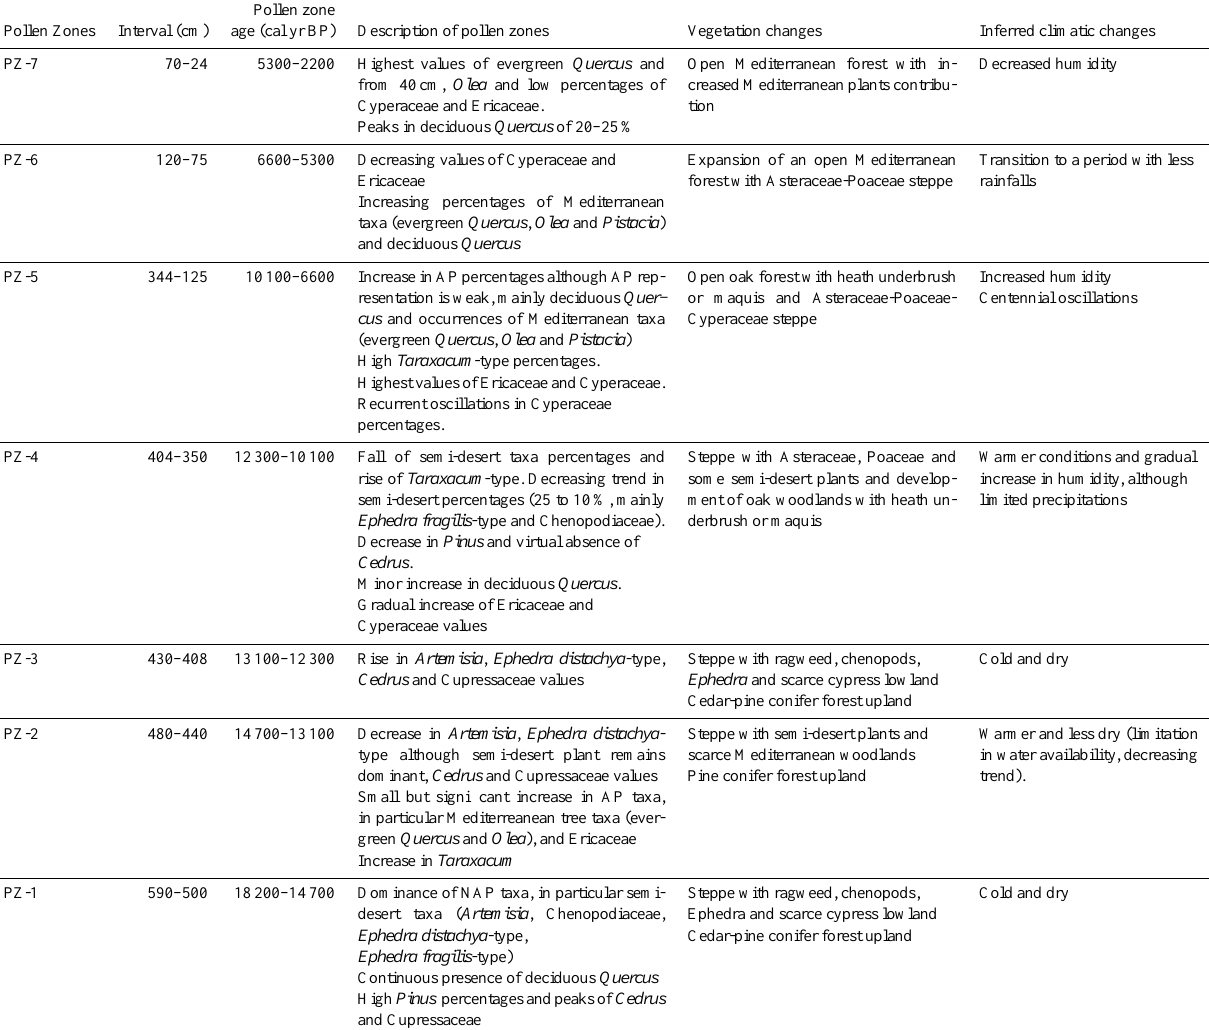
Table 2. Description of the MD04-2797CQ pollen